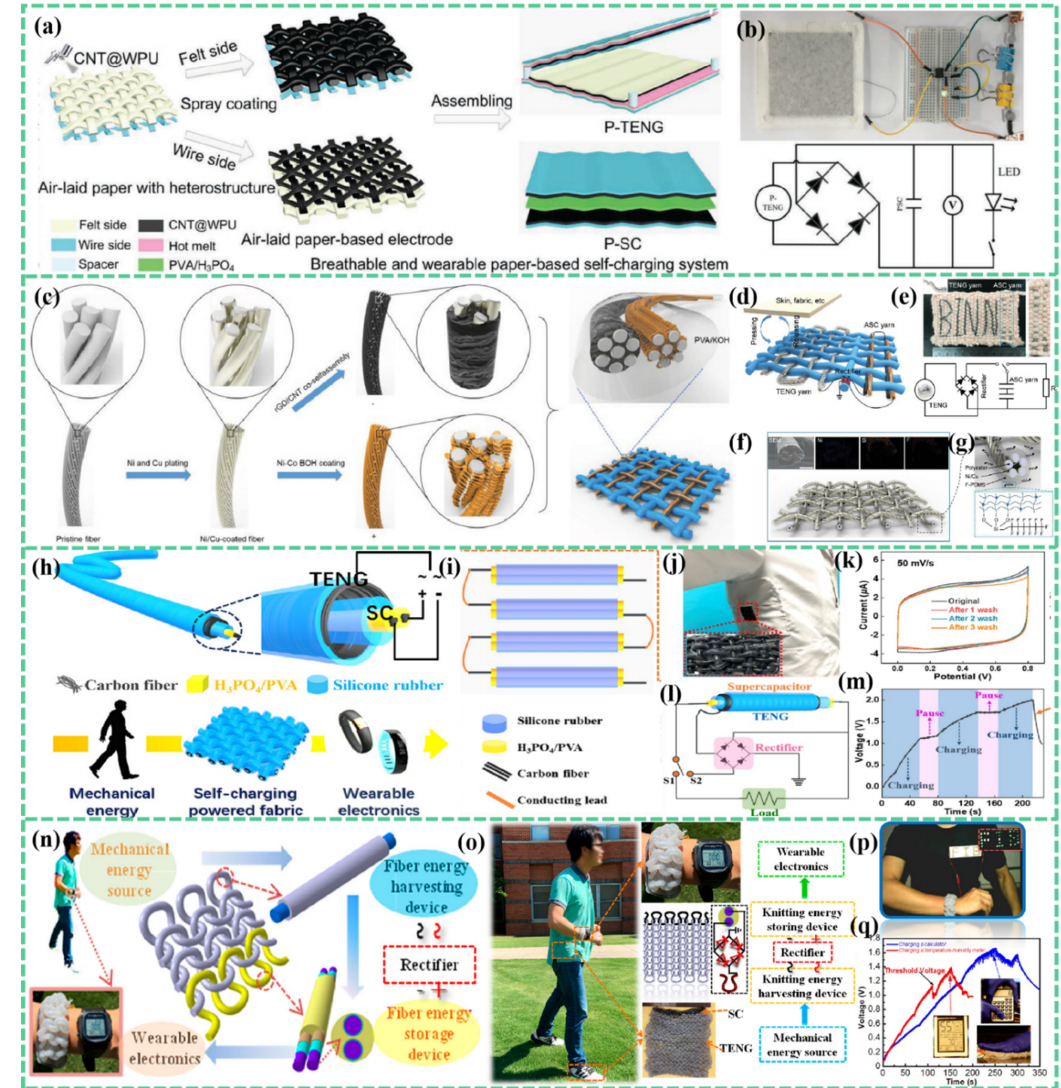
Figure 2. Wearable TENG-UPS textile integrated with TENG and SC. ( a – b ) A breathable and wearable TENG-UPS is developed by integrating P-TENG and P-SC. ( a ) Structure of a breathable and wearable TENG-UPS. ( b ) Digital image and circuit diagram of TENG-UPS. Reproduced with permission [70]. Copyright 2019, Wiley-VCH. ( c – g ) TENG-UPS composed of energy collection TENG and energy storage yarn type asymmetric SC. ( c ) Schematic illustration of the fabrication procedure of Y-ASC. ( d ) Schematic illustration of the TENG-UPS. ( e ) Photograph of a TENG-UPS textile. ( f ) Schematic illustration of a TENG textile woven by Ni-coated conductive yarns with a shell coating of F-PDMS. ( g ) A scheme of the surface fluorine-containing groups on the chemically modified F-PDMS. Re- produced with permission [71]. Copyright 2019, Wiley-VCH. ( h – m ) A flexible coaxial TENG-UPS fiber with a fiber-shaped TENG outside and a fiber-shaped SC inside. ( h ) Fabrication process of the coaxial TENG and SC fiber. ( i ) Schematic illustration of the series connection of the integrated SCs. ( j ) Photograph of the fabricated textile into cloth. ( k ) GCD curve of SC before and after three times of washing. ( l ) Circuit diagram of the SCPs. ( m ) Charging and operating curve of SC. Reproduced with permission [72]. Copyright 2018, American Chemical Society. ( n – q ) A highly stretchable and washable all-yarn-based TENG-UPS knitting power textile composed of fiber TENG and fiber SC. ( n – o ) System configuration of self-charging knitted strong textiles. ( p ) LED warning sign on a shirt. ( q ) Charging curves. Reproduced with permission [73]. Copyright 2017, American Chemical